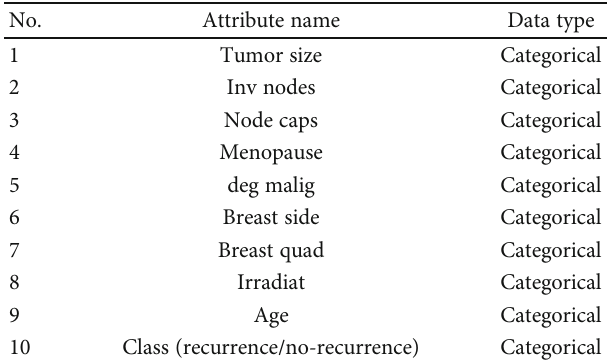
Table 4: The features of BC